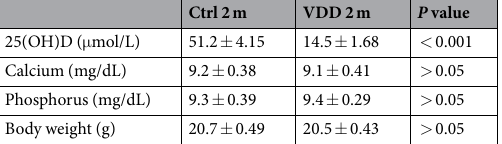
Table 1. General data of the control and vitamin D deficiency mice. Ctrl: control; VDD: vitamin D